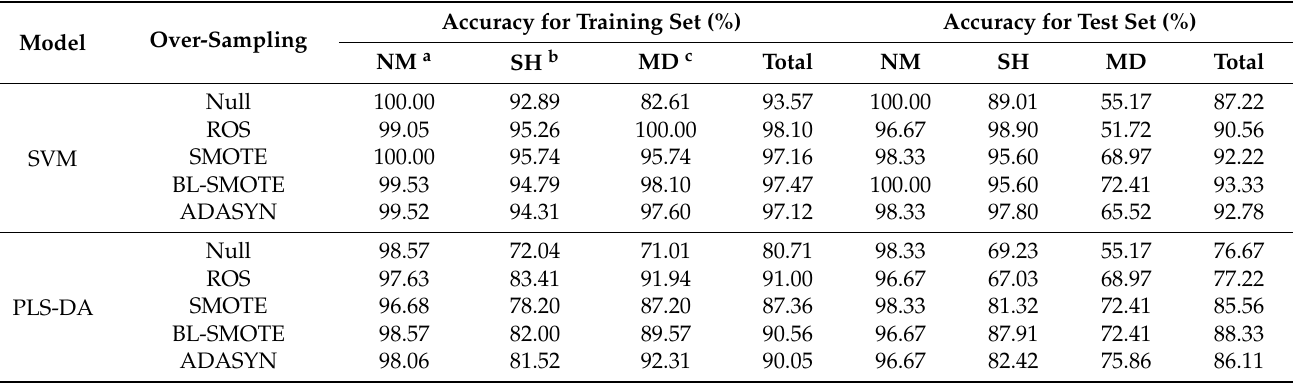
Figure 3. Spectral reflectance curves of dried Hami jujube in different states. ( a ) Mean reflectance spectral curves, and spectral curves with standard deviation for ( b ) normal jujube, ( c ) starch-head fruit, and ( d ) mildewed fruit. Table 1. The discrimination results based on different oversampling